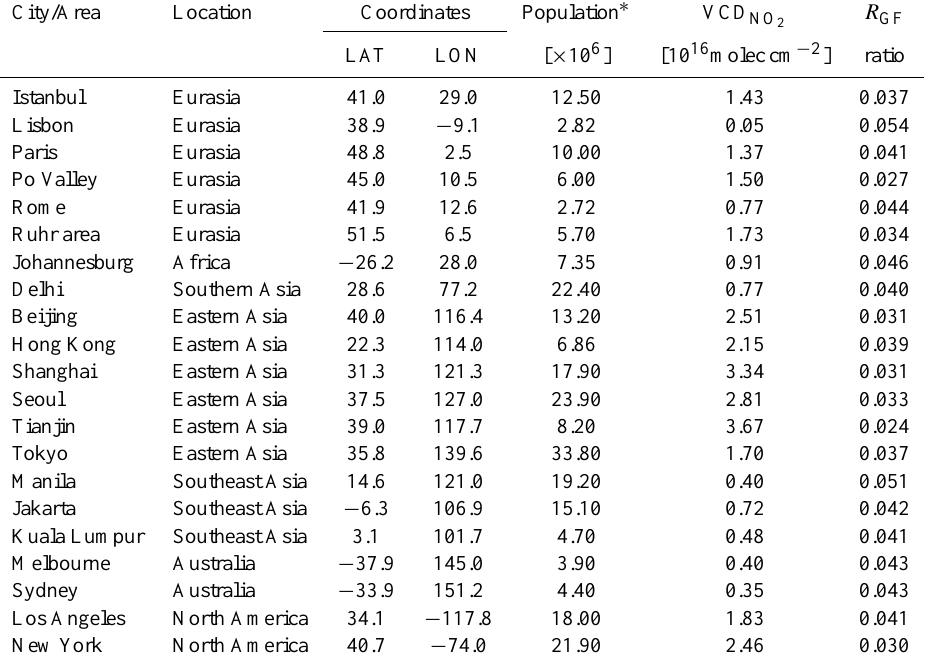
and R GF corresponds to a box region of dimensions 0.25 × 0.25 ◦ 2